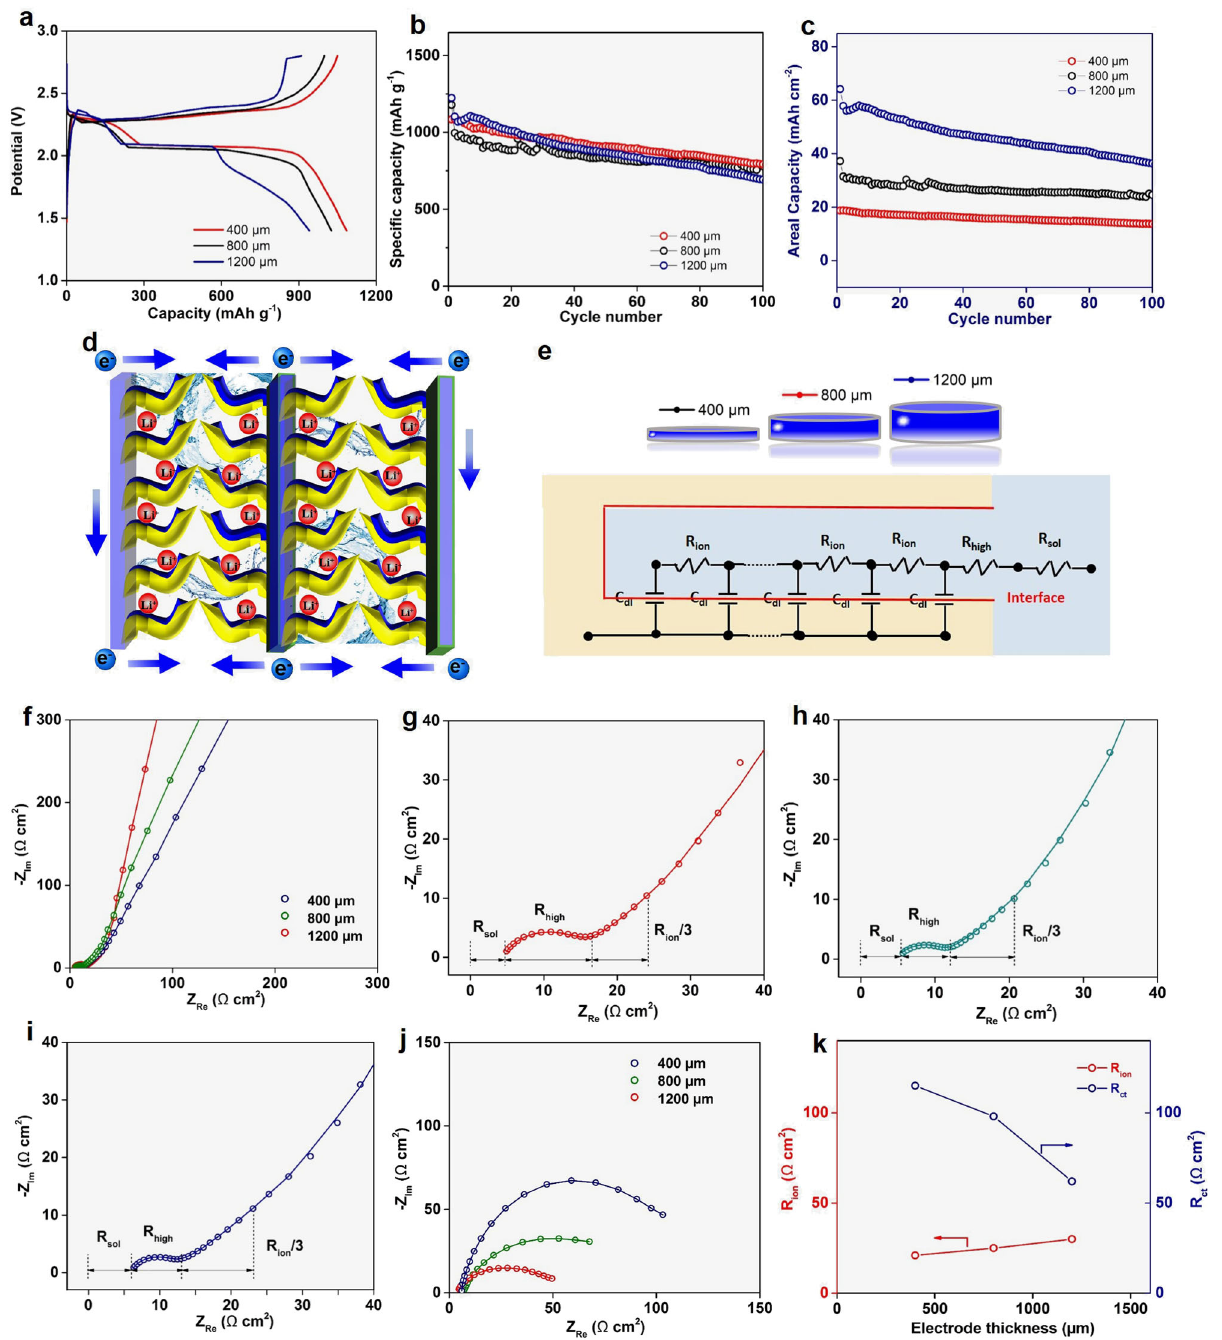
Fig. 4 Electrochemical performance and kinetic analysis of S@WLC-CNTs electrodes with different thicknesses and areal sulfur loading. a Tenth cycle discharge/charge curves and b , c cyclability of S@WLC-CNTs electrodes with different thicknesses and sulfur content at the 0.1 C rate. d Conceptual schematic representation of Li-ion fl ow and electron transfer in the integrated S@WLC-CNTs electrode. e Equivalent circuit using the transmission line model. f Nyquist plots of symmetric cells with different thicknesses using two identical positive S@WLC-CNTs electrodes at 0% SOC. Magni fi ed Nyquist plot of S@WLC-CNTs electrodes with thicknesses of g 400 μ m, h 800 μ m, and i 1200 μ m. j Nyquist plots for symmetric cells with different thicknesses using two identical positive S@WLC-CNTs electrodes at 50% SOC. k R ion and R ct comparison between electrodes with different